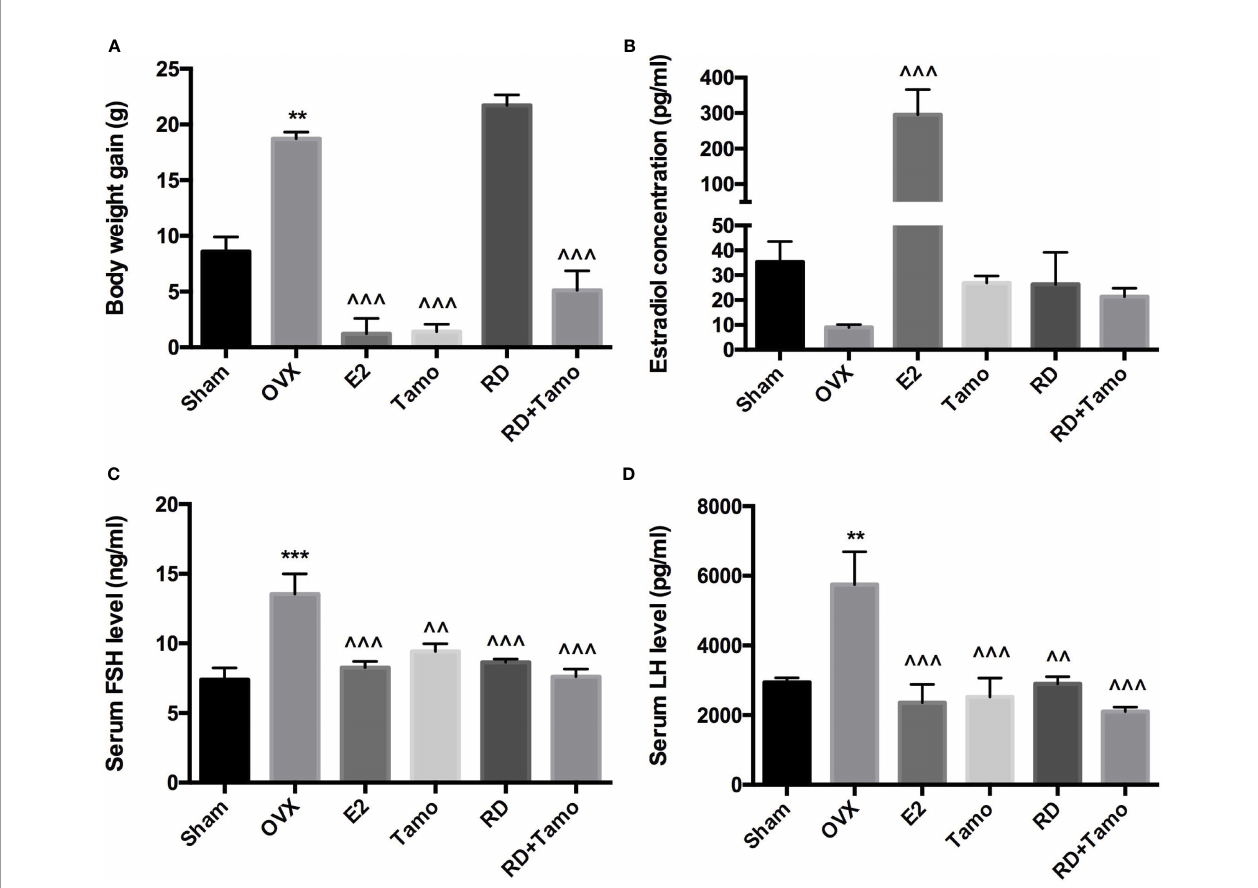
FIGURE 1 | Estrogenic effects of RD, tamoxifen, and their combinations on body weight gain and circulating hormone level in mature ovariectomized rats. Six- month-old mature Sprague Dawley sham-operated (Sham) or ovariectomized (OVX) rats were treated with either vehicle, E2 (1.0 mg/kg/day), RD (0.2 g/kg/day), tamoxifen (Tamo, 0.1 mg/kg/day), or their combination for 12 weeks. (A) Body weight gain of OVX rats after 12-week treatments. (B – D) Circulating level of estradiol, FSH, and LH was measured by using EIA kit (CayMan). Data were expressed as mean ± SEM. n = 6 to 10. *** p < 0.001, ** p < 0.01 vs. Sham; ^^ p < 0.01, ^^^ p < 0.001 vs. OVX. p -value of two-way ANOVA: 0.7253 for body weight, 0.1104 for estradiol concentration, 0.0239 for serum FSH, and 0.0331 for serum